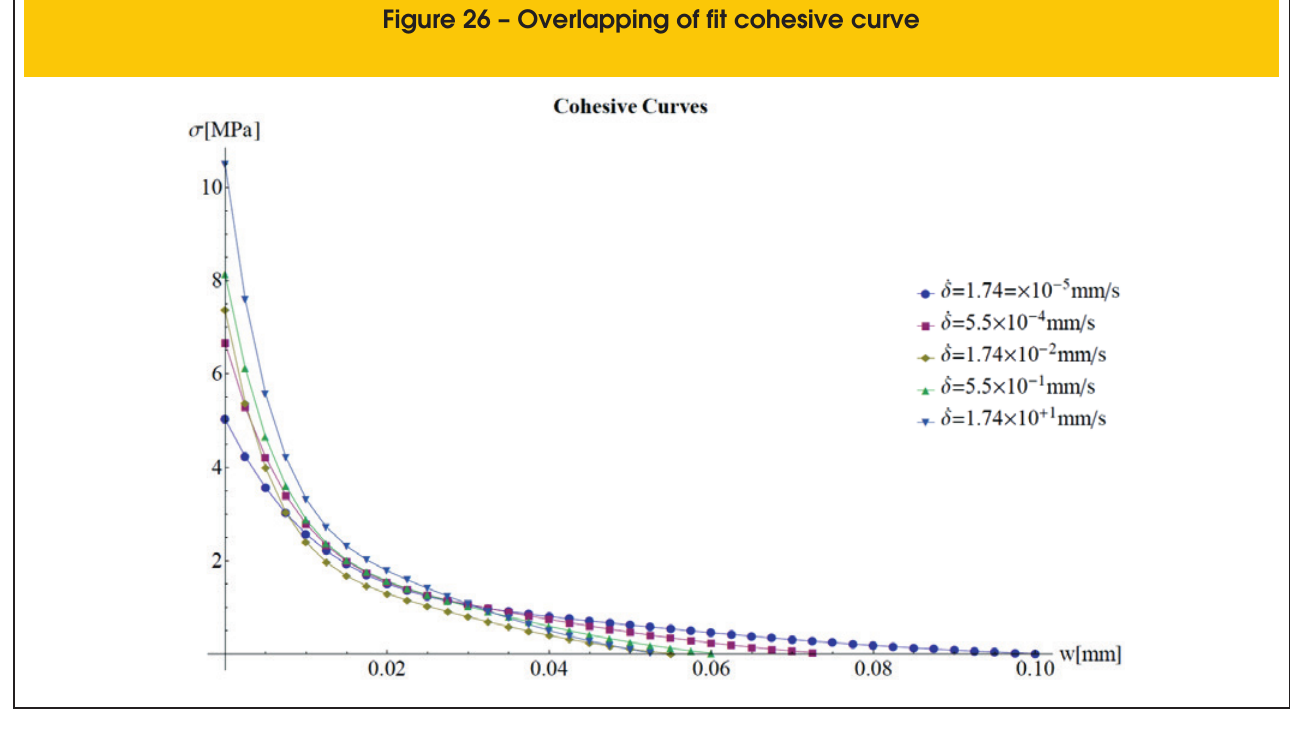
Figure 26 – Overlapping of fit cohesive